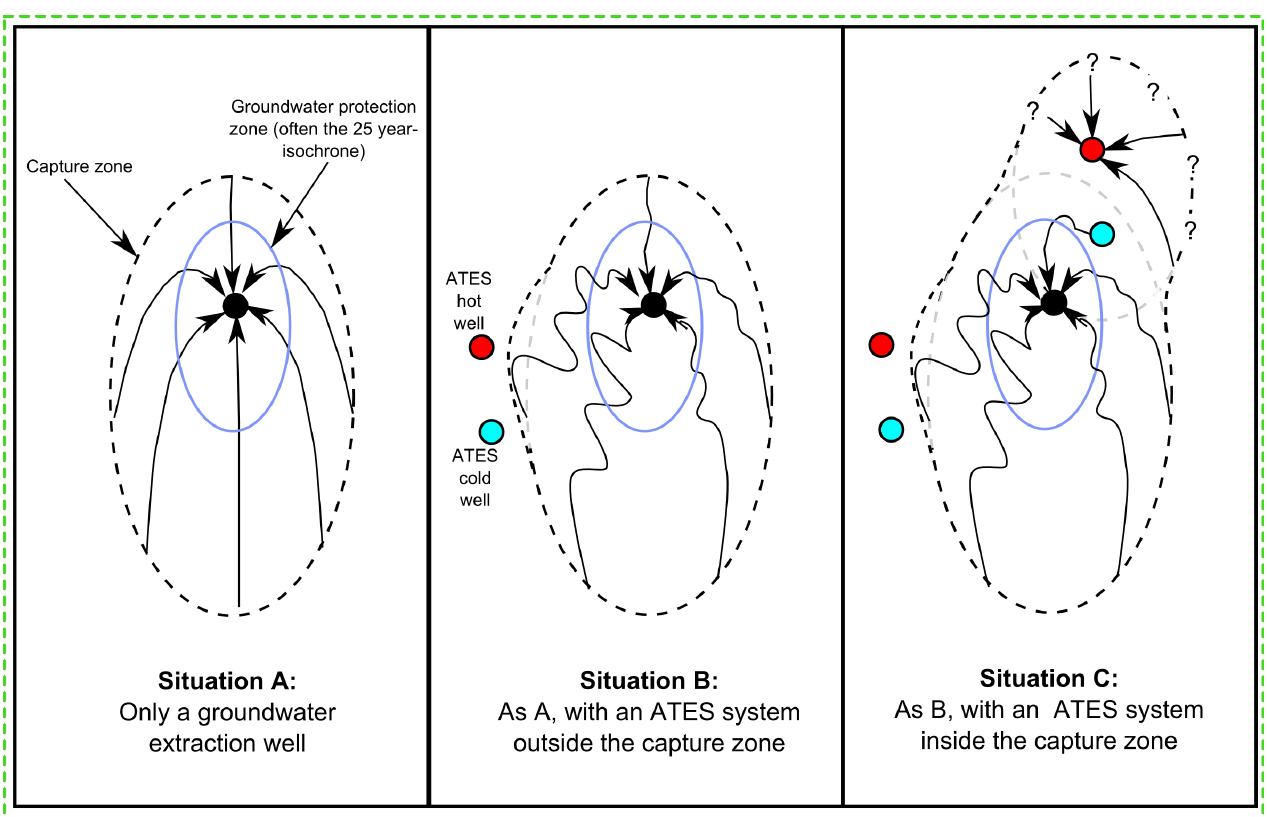
Fig. 3. Conceptual illustration of the effects of an aquifer thermal energy storage (ATES) system: alone (A), just outside the capture zone of a public supply well (B), and just inside the capture zone of a public supply well (C). Arrows indicate the path of groundwater flow; red and blue circles are the hot and cold wells, respectively, of an ATES